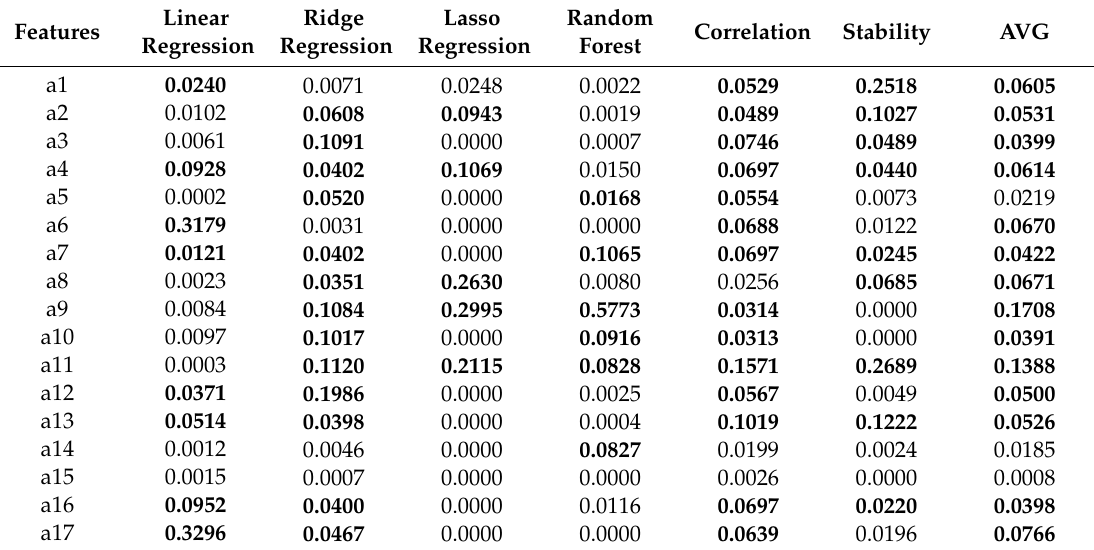
Table 1. Contribution of features by di ff erent selection methods for the G dataset.